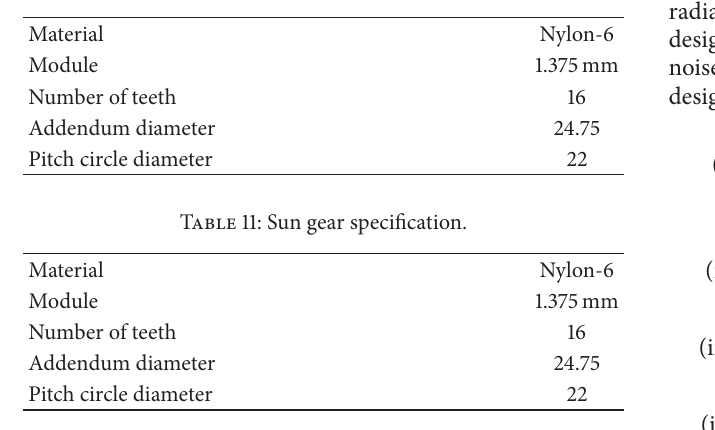
Table 10: Planet gear specification.